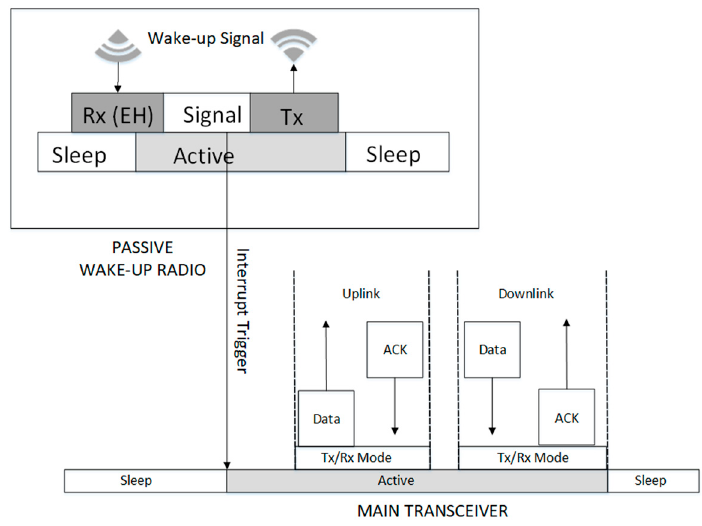
Figure 6. Wake-up relay process.